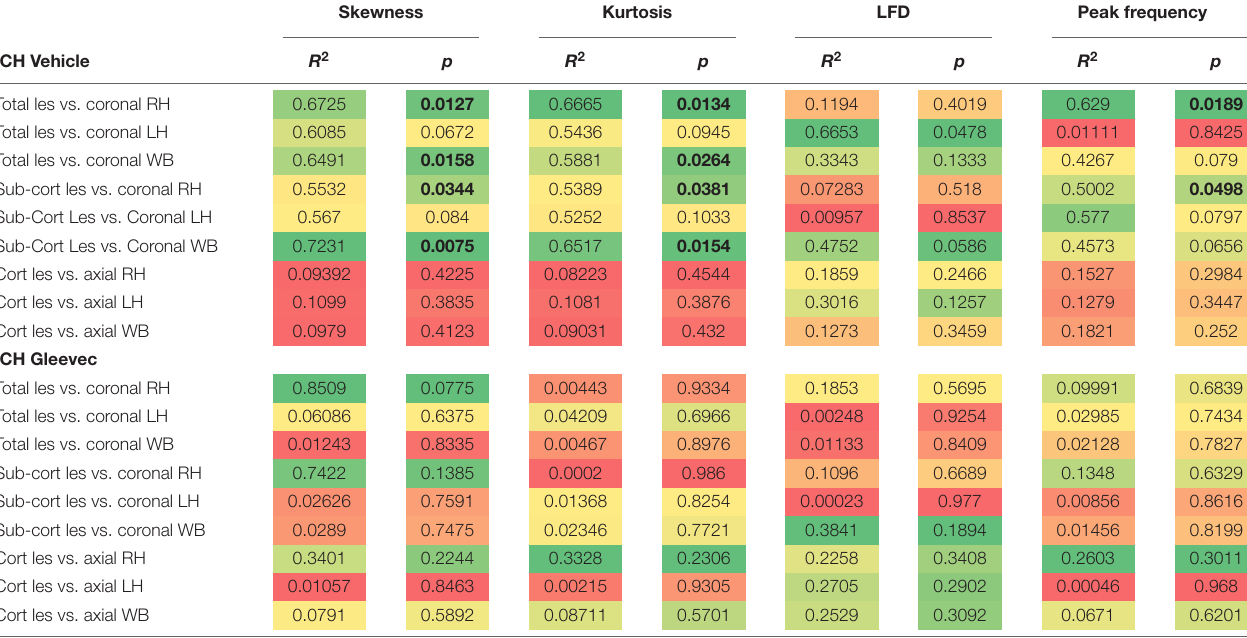
TABLE 1 | Summary of correlations between MRI derived lesion volumes and fractal vascular features where strong correlations (green) are color coded, as are p -values. Skewness Kurtosis LFD Peak